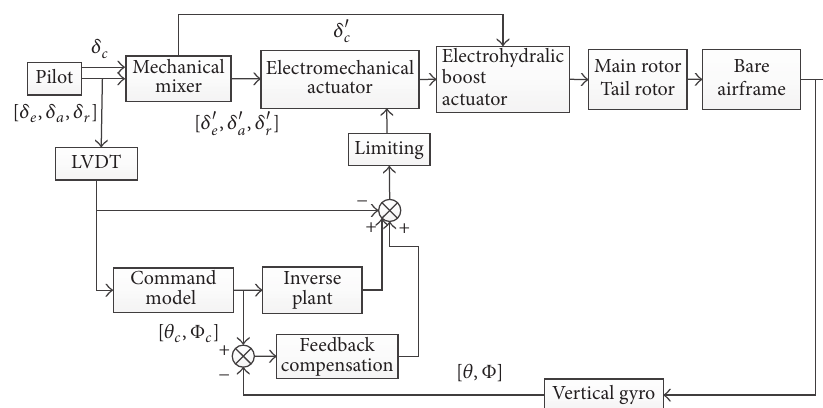
Figure 2: Implementation of ACAH mode into UH-60’s MCLAWS model following control